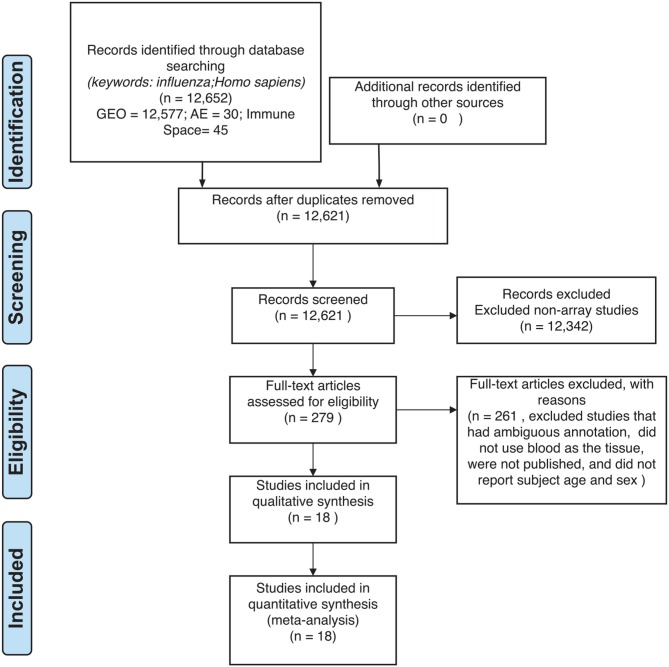
Preferred reporting items for systematic reviews and meta-analyses (PRISMA) checklist.